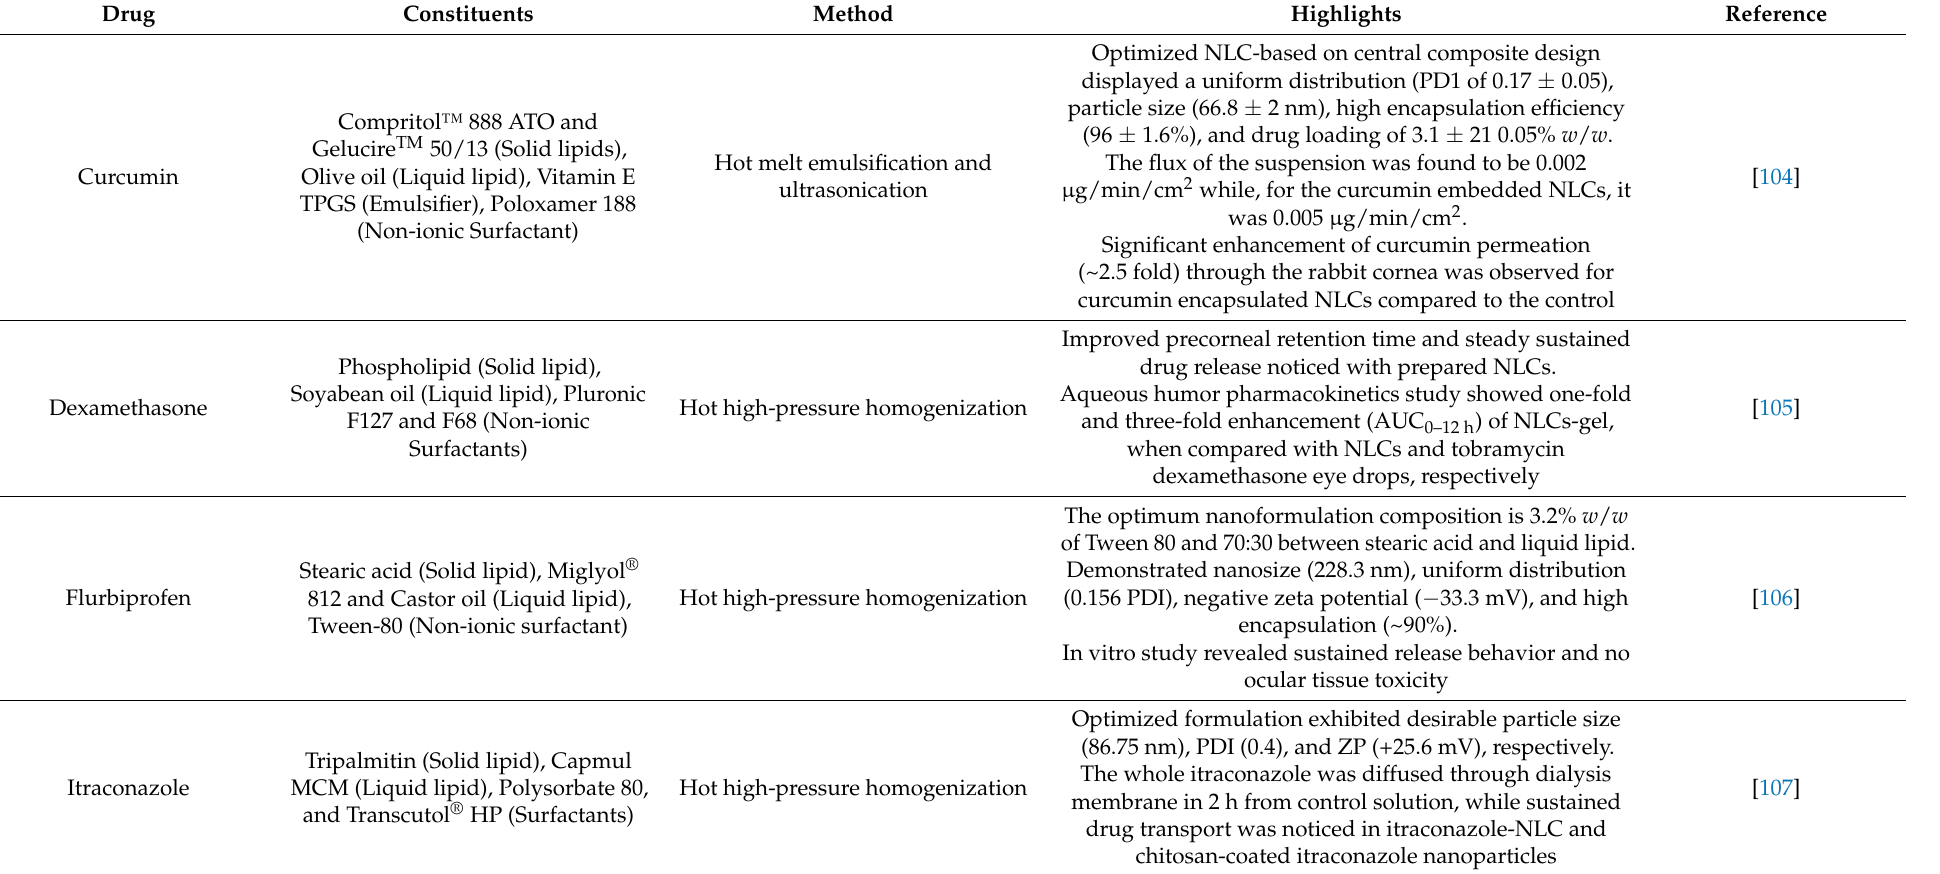
Table 4. Selected examples of nanostructured lipid carriers based on ocular formulations and key